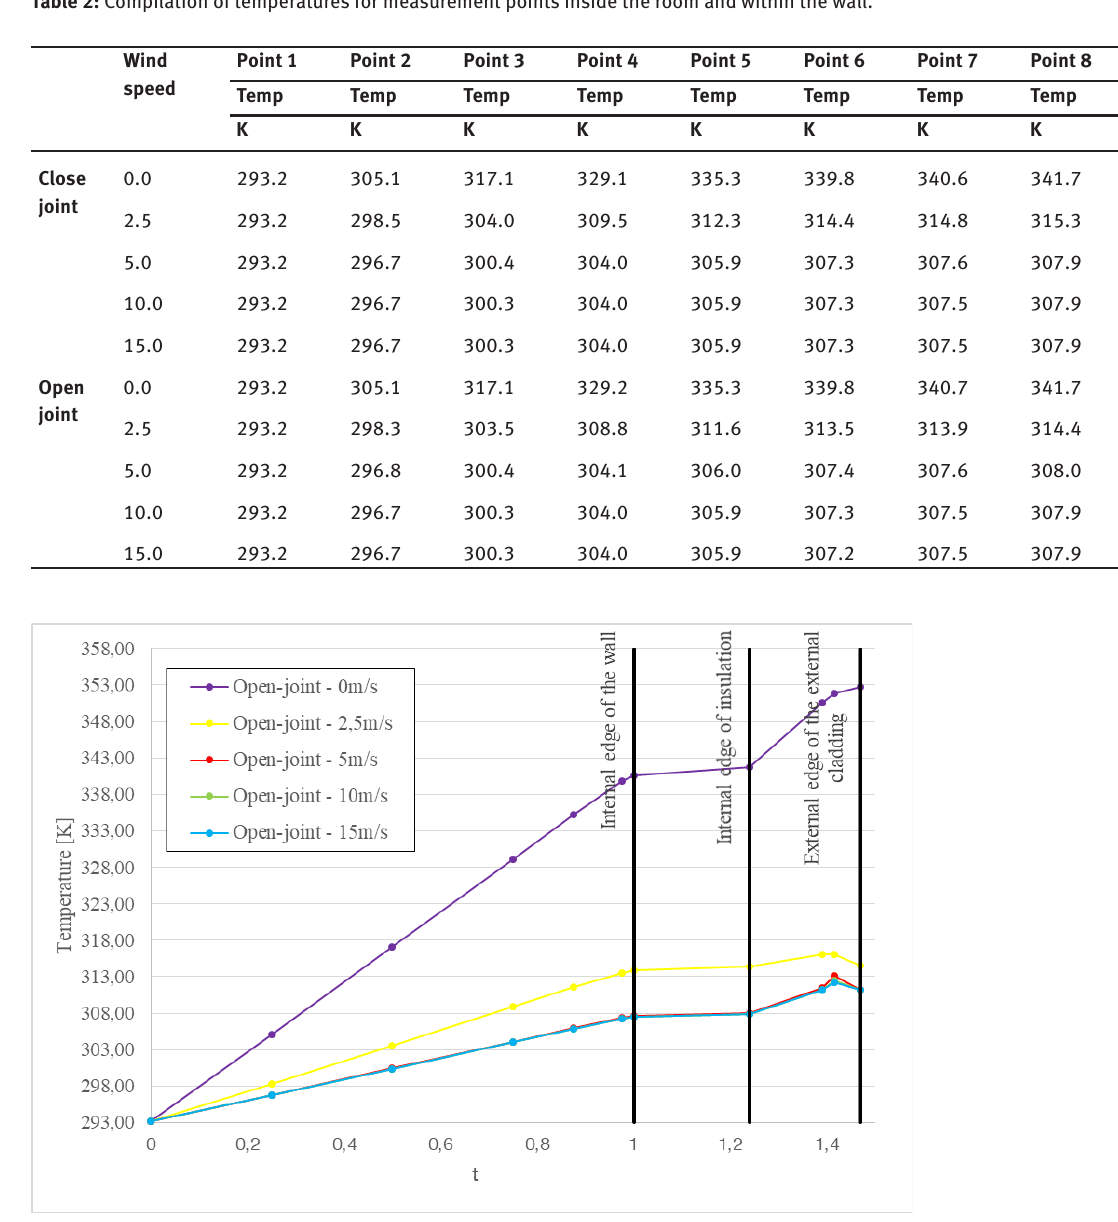
Figure 15: Temperature overview for the control points of the open-joint